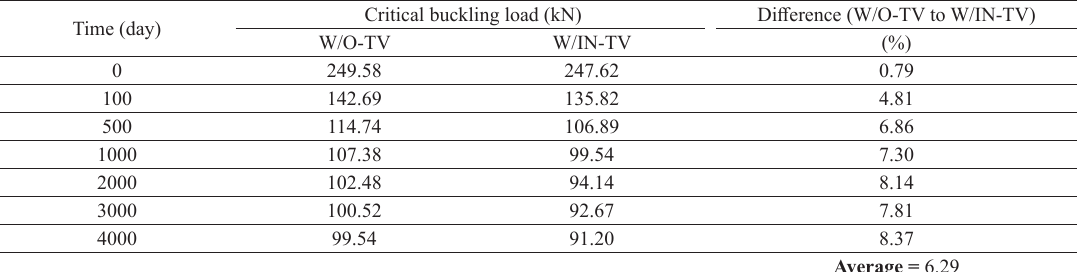
W/O-TV = without thermal variation; W/IP-TV = with positive thermal variation. Table 2. Obtained results from ∆ T = 0ºC and ∆ T = - 15ºC. Critical buckling load (kN) Time (day)